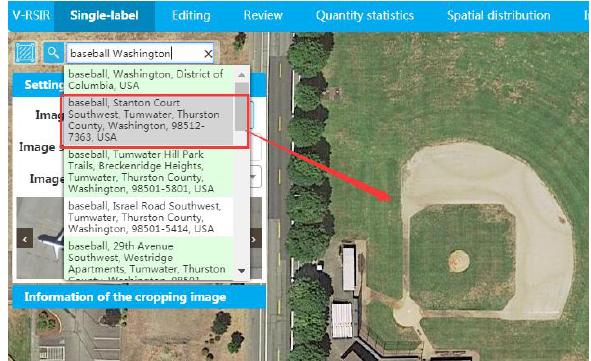
Figure 3. Interface of search